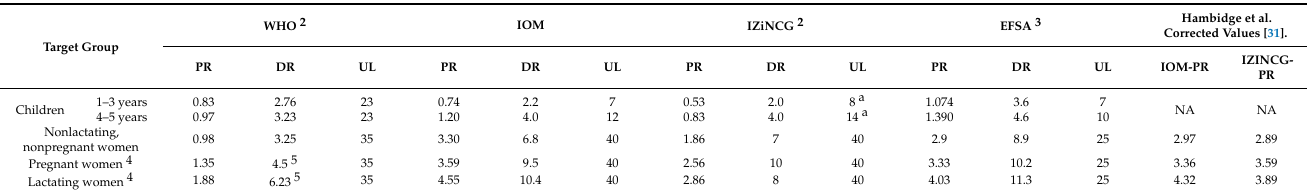
Table 1. NRVs (mg/day) for young children and women of reproductive age, as developed by the WHO, IOM, IZiNCG, and EFSA 1